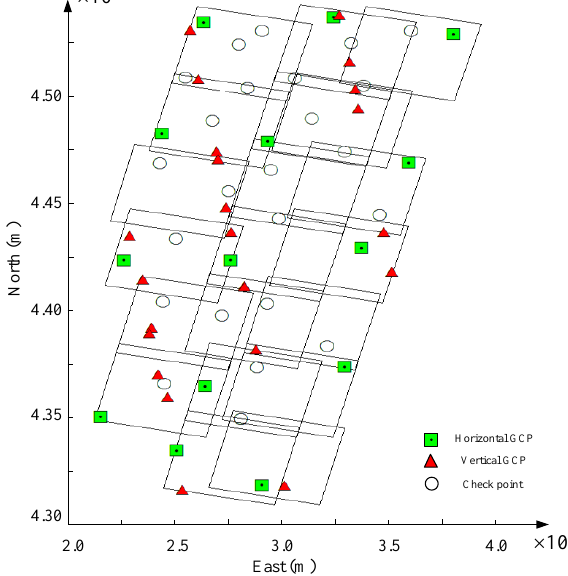
Figure 5. The point distribution for block adjustment experiment in the Taihang Mountain region. The vertical GCP is derived from GLAS points, horizontal GCP and CP are determined by GPS field